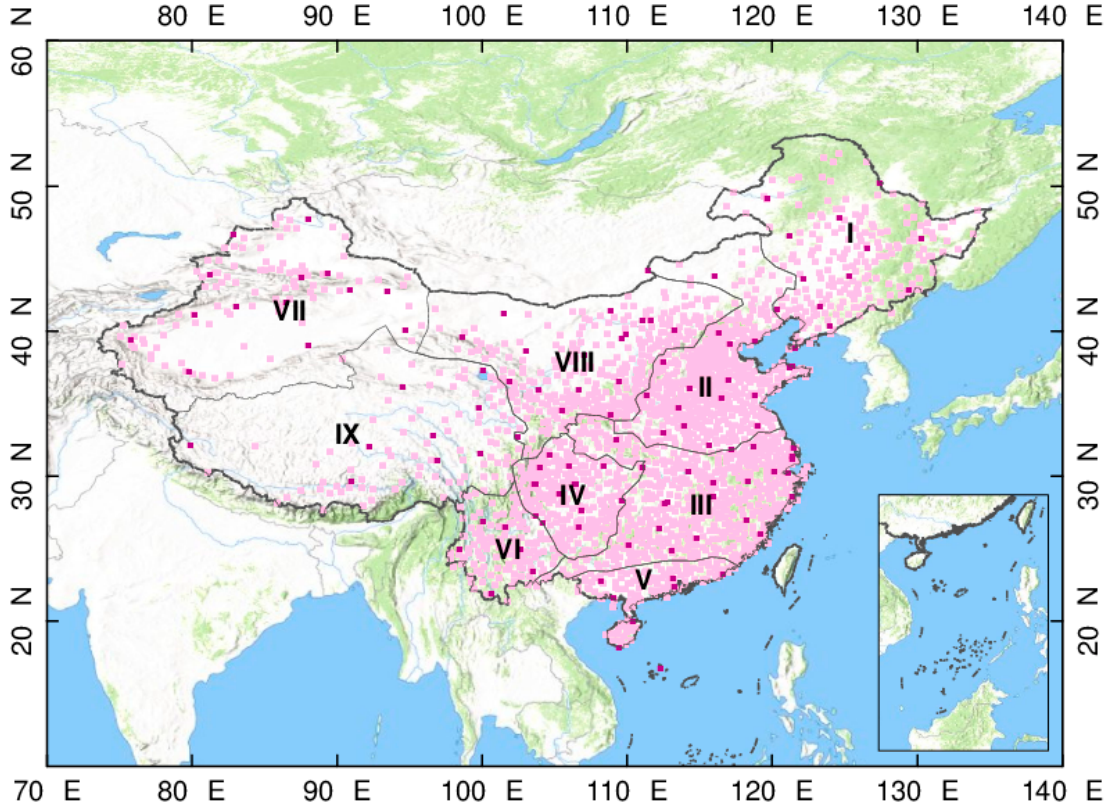
Figure 1. The ~2400 sunshine duration (SunDu) merged sites are shown as light pink points, and 121 independent validation sites are shown as dark pink points. The whole region is classified into nine subregions (I to IX) by the K-mean cluster method based on geographic locations and multiyear mean R s using 121 R s validation sites. The base hill shade map was produced by an elevation map of China using the global digital elevation model (DEM) derived from the Shuttle Radar Topography Mission 30 (SRTM30) dataset.